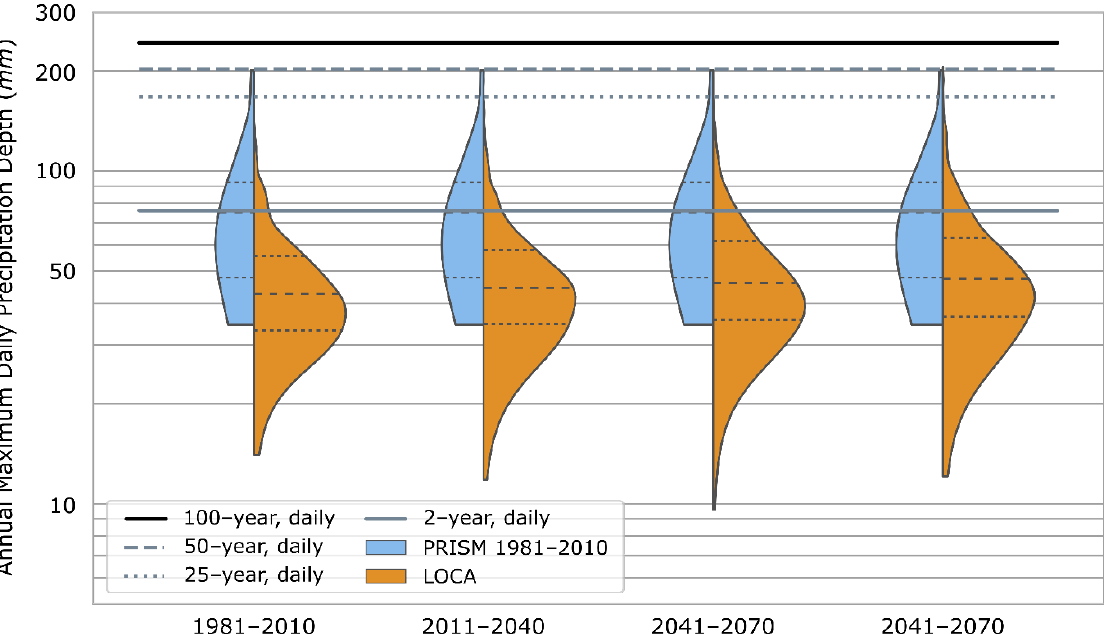
Figure 7. Observed, empirical distribution of individual grid cell, annual maximum, daily precipitation depth. A violin plot combines the box plot format with a kernel density estimator to provide a smoothed depiction of an empirical distribution [66], in this case the distribution of annual maximum, daily precipitation depth. The horizontal, dashed lines within the shaded portions of the violin plots identify the three inner quartile thresholds (i.e., 25th, 50th, and 75th percentile or 1/4, 1/2, and 3/4 quantiles). Daily extreme event magnitude estimates by recurrence interval come from NOAA Atlas 14 [67] 24-h event magnitude estimates that are divided by 1.13, which is a conversion multiplier to convert from daily extreme values to 24-h extreme values [68].